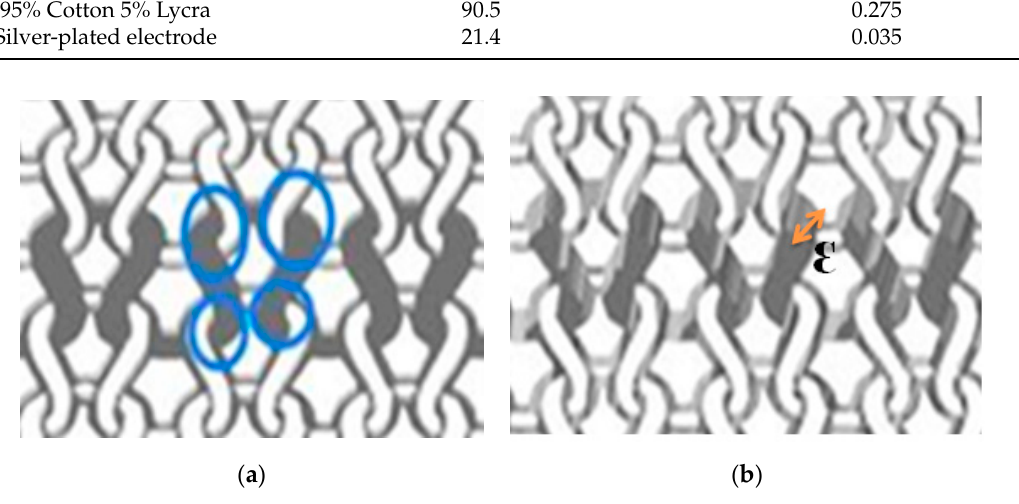
Figure 4. Stitch pattern of ( a ) thinner and ( b ) thicker single jersey fabric (contact between loops noted by blue circles). Table 2. Surface resistivity of textile electrodes.